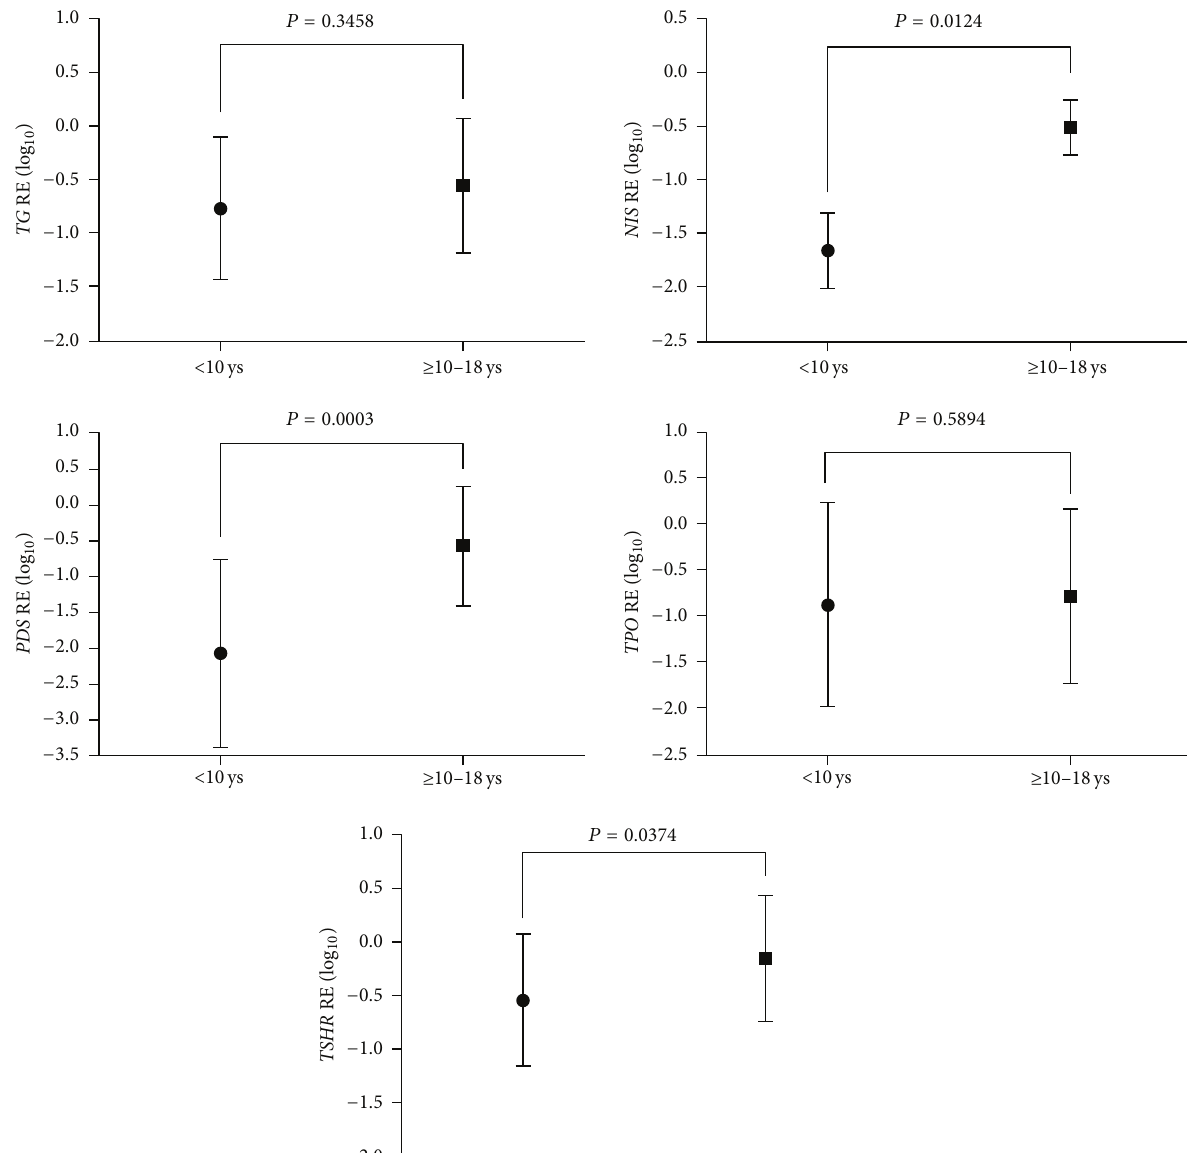
Figure 2: Relative expression (RE) of thyroid-specific genes in pediatric thyroid carcinomas classified according age: children ( 𝑛 = 13 ; < 10 years old) or adolescents ( 𝑛 = 25 ; ≥ 10 years old). The graphics shows the mean ( ± SD). Data was log-transformed before analysis. 𝑃 < 0.05 were considered statistically